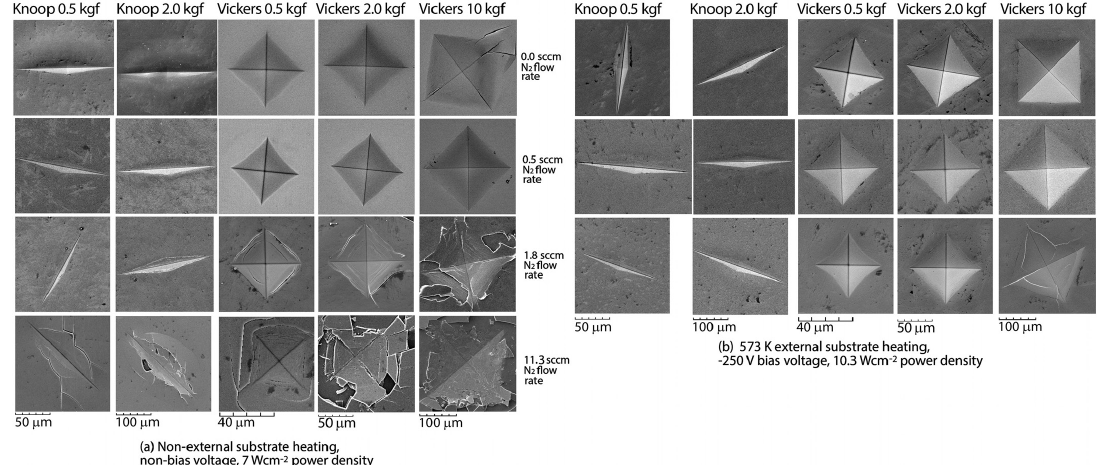
Figure 6. Surface appearance of selected samples studied by Knoop and Vickers indentation as observed in the SEM facility. Secondary electrons. Surfaces not chemically